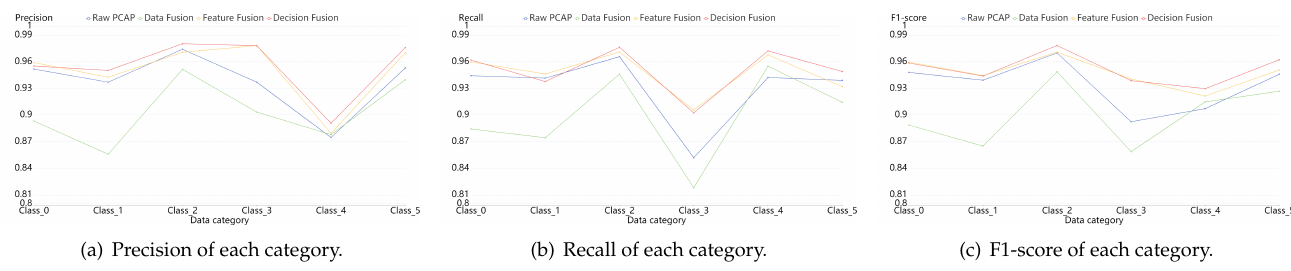
Figure 13. Classification results of each category on dataset VPN2016. They are composed of Precision, Recall and F1-score which are calculated by a simple model with PCAP data, data fusion model, feature fusion model and decision fusion model.